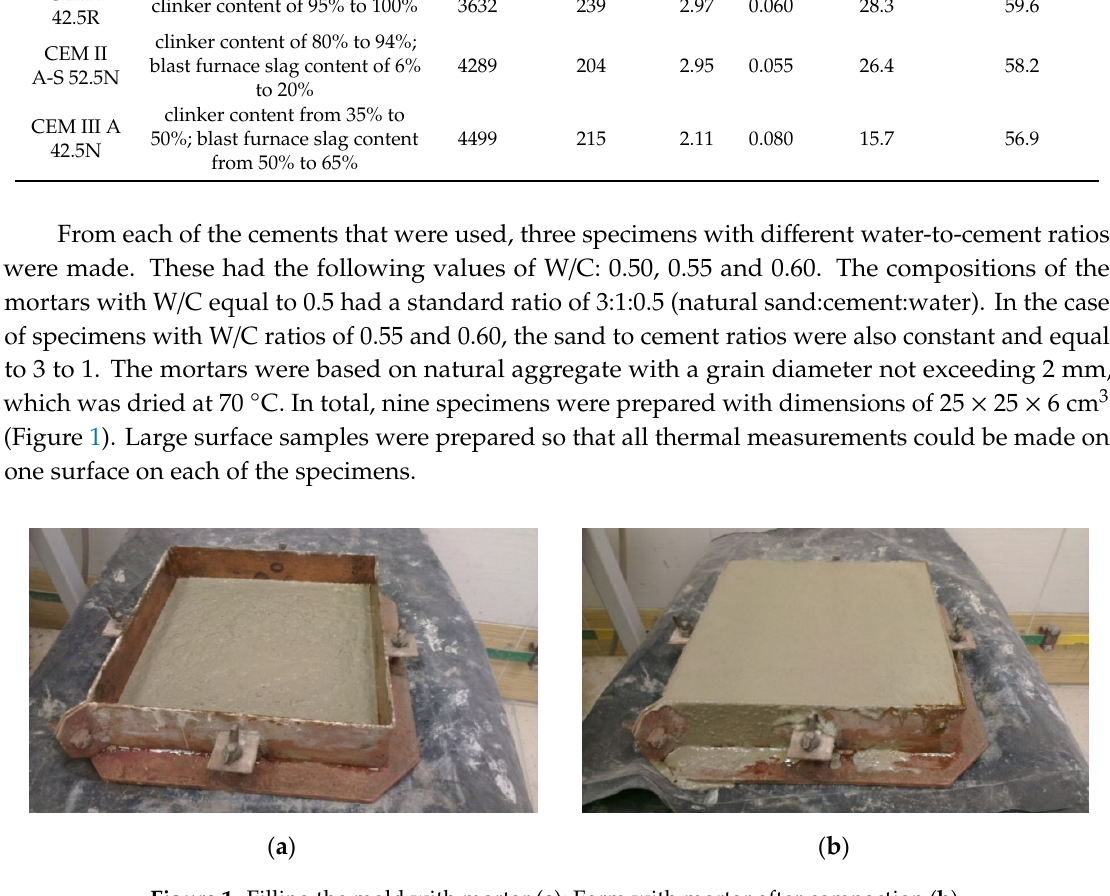
Figure 1. Filling the mold with mortar ( a ); Form with mortar after compaction ( b